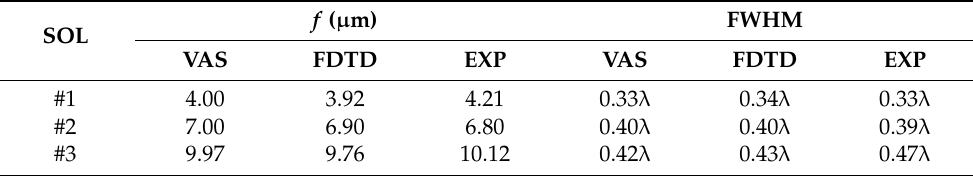
Table 2. The VAS, simulated, and experimental focal lengths, and FWHMs, for the three samples. f ( µ m) FWHM SOL VAS FDTD EXP VAS FDTD